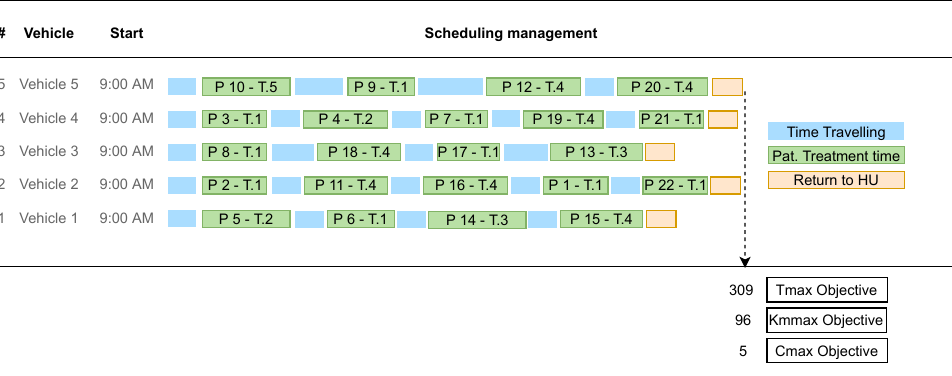
Figure 5. Planning management of the non-dominated solution